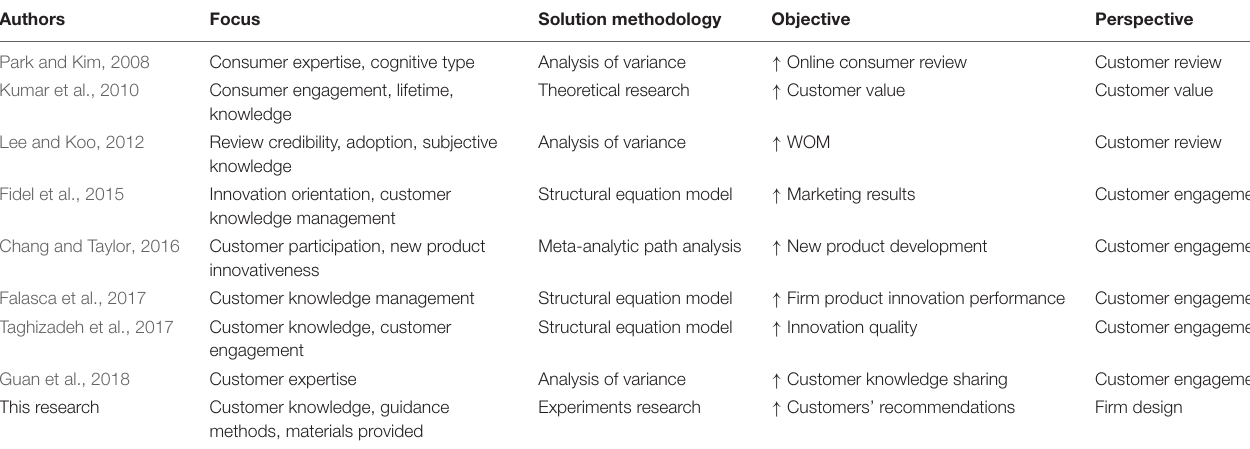
TABLE 1 | Proposed design positioned into the